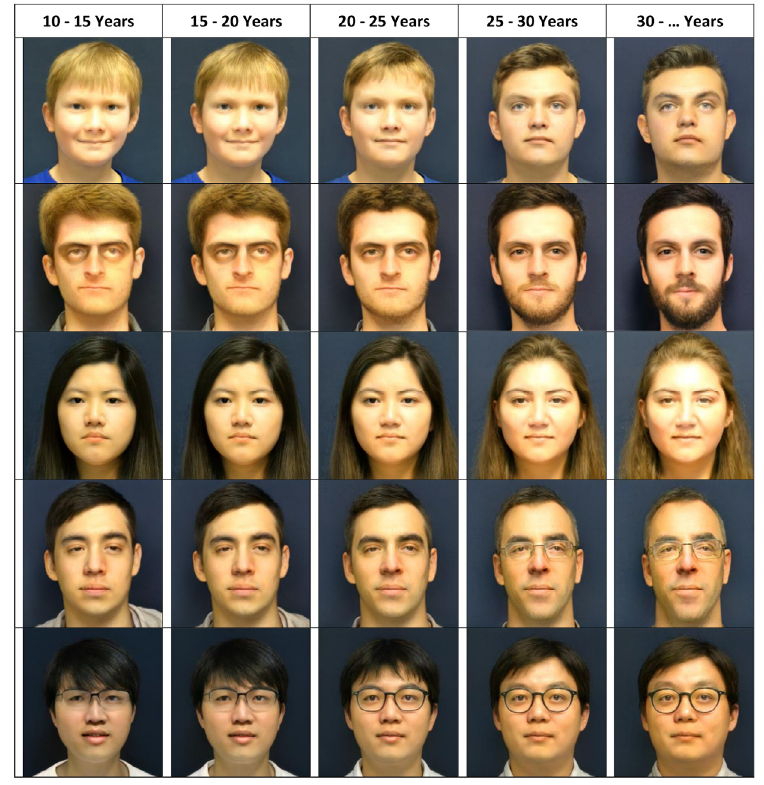
Figure 5. Model trained on F1L2M8 tested on Tufts face dataset sample set 1.